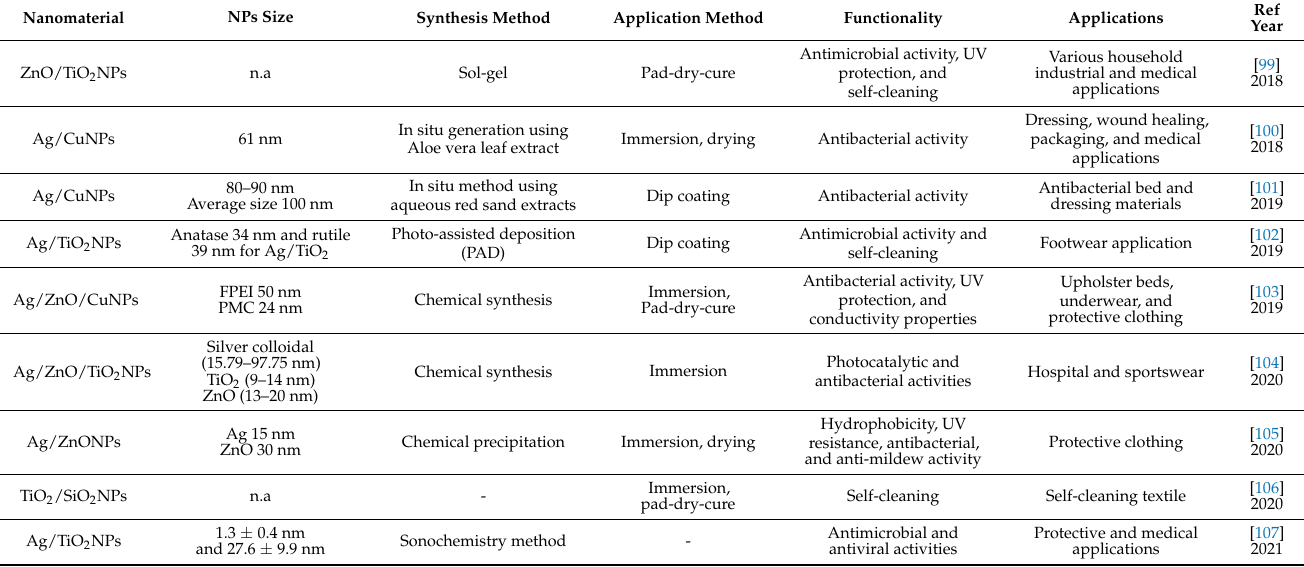
Table 7. Summary of the functionalization of cotton fabrics with mixtures of nanoparticles and their